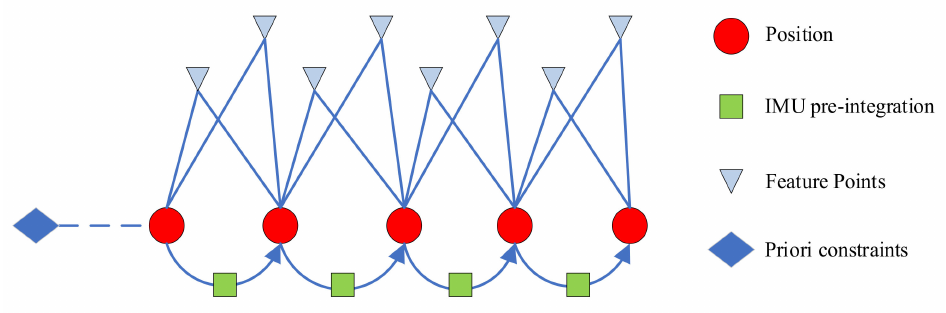
Figure 4. Back-end optimization